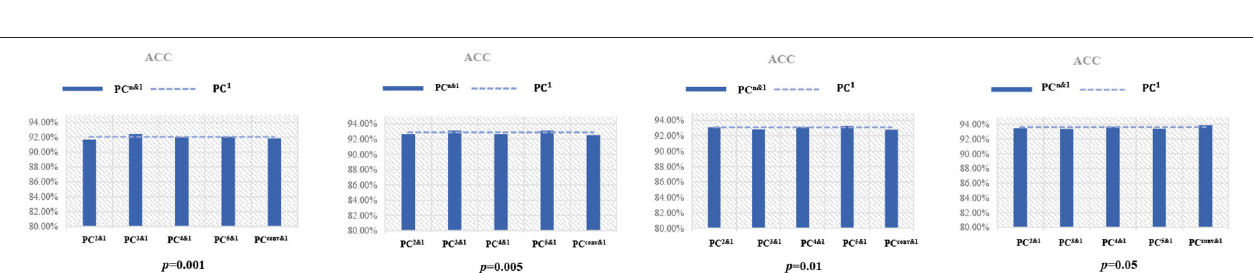
FIGURE 7 | The SEN and SPE based on six kinds of BFNs for MCI identification, respectively. It can be observed that the SEN and SPE of PC 1 is better than other cases. In addition, under different p -values of t -test, the SEN and SPE tend to change greatly.